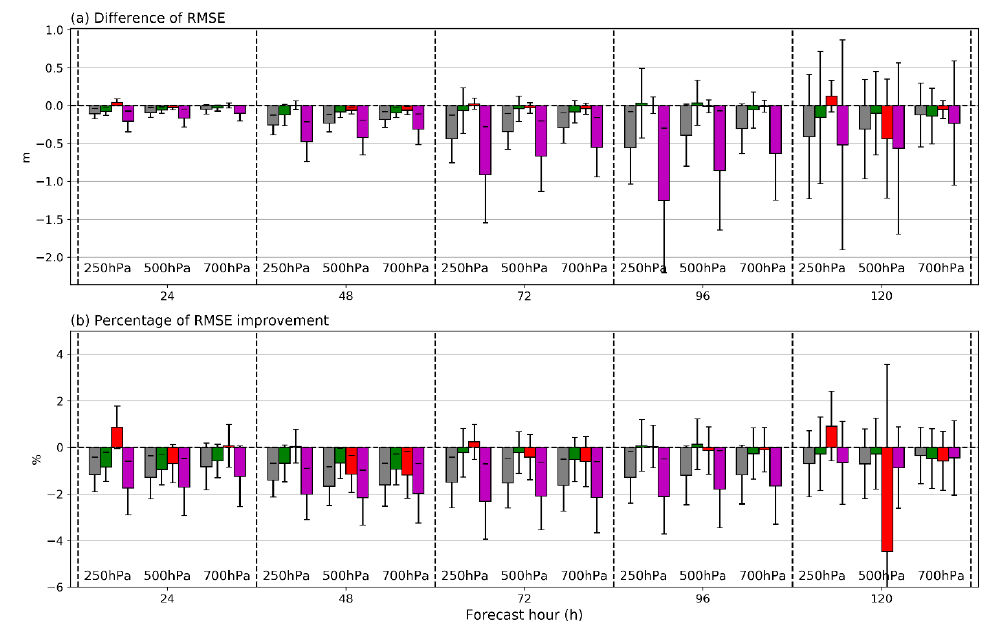
Figure 8. The ( a ) mean and ( b ) normalized di ff erence of RMSE of 250 hPa, 500 hPa, and 700 hPa geopotential height forecast up to 120–h forecast hours between the latency_20m and control runs. Grey, green, red, and magenta boxes indicate the results over the Global, Northern Hemisphere, Tropic, and Southern Hemispheres, respectively. Vertical bars representing 95% confidence level of the uncertainty are overlaid.